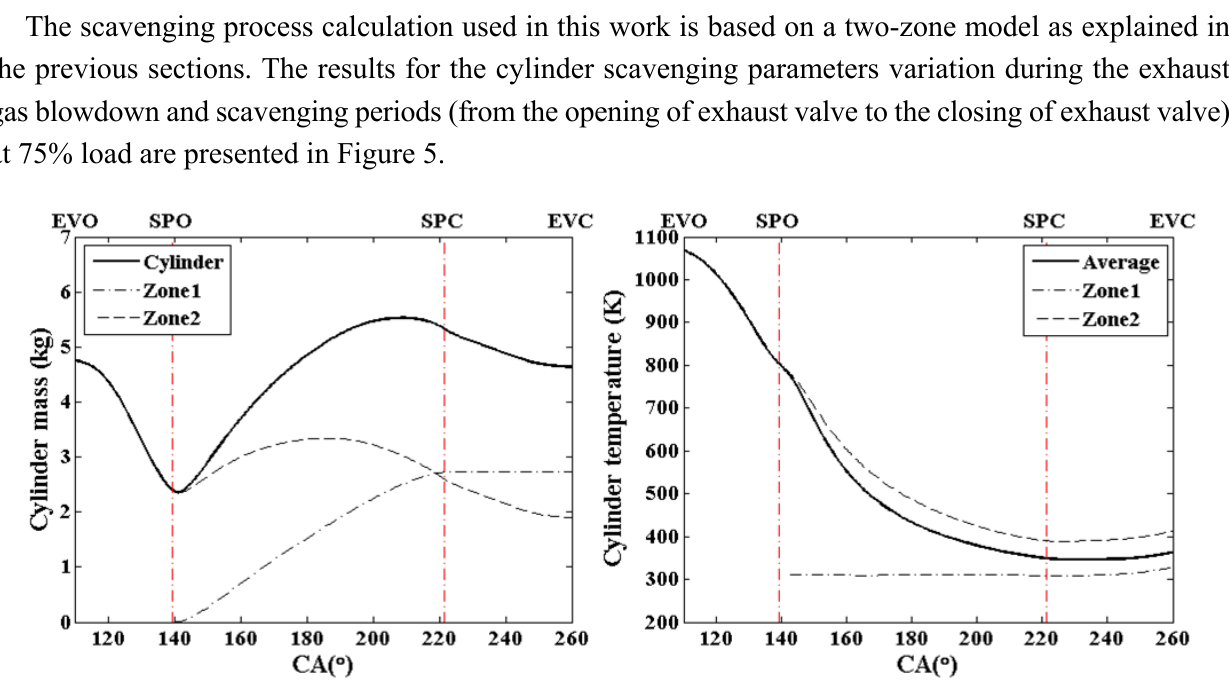
Figure 5. Scavenging model results for engine operation at 75%